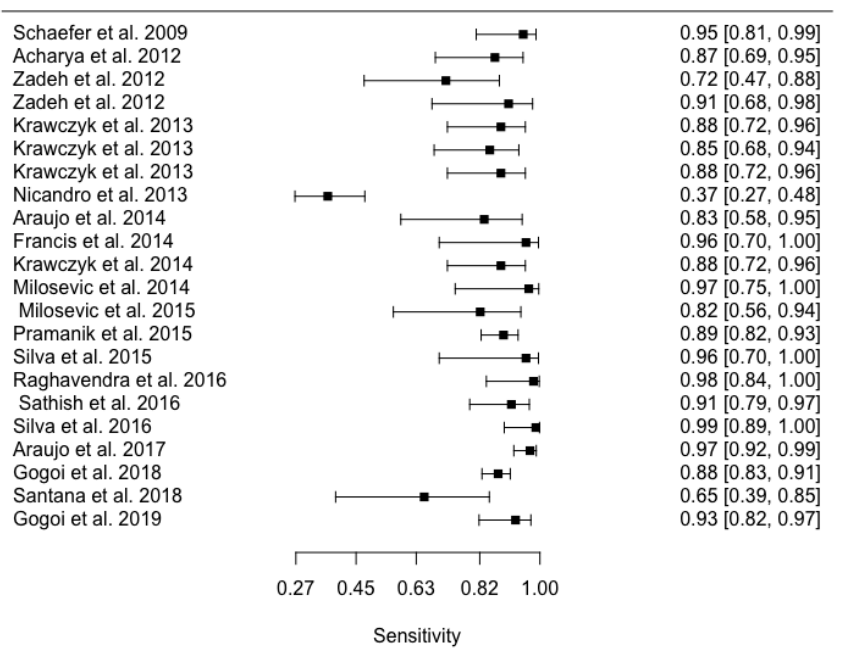
Figure A1. Forest plots for sensitivity for breast cancer studies.